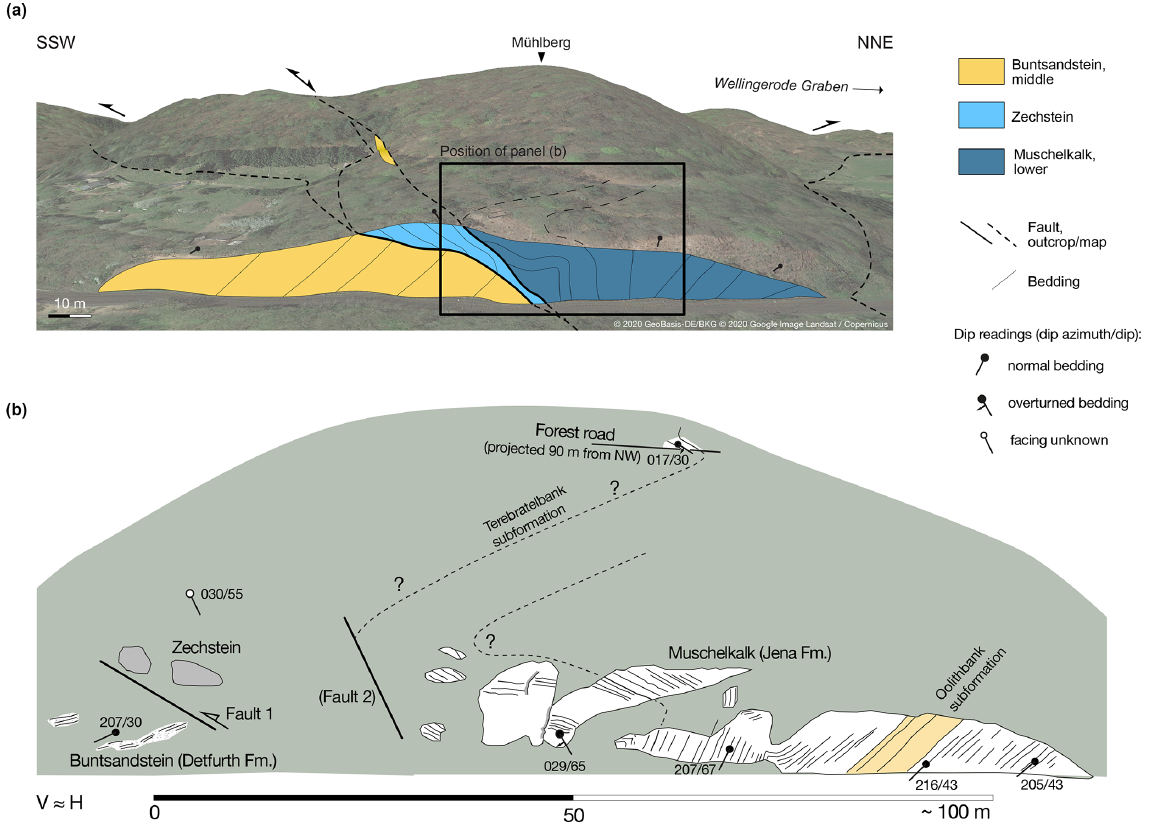
Figure 4. (a) Outcrop along the train tracks west of Sontra (Schröder, 1925) shown as an overlay on a GoogleEarth image with fault traces extrapolated according to our own field data. (Image position 51 ◦ 4 (cid:48) 57.35 (cid:48)(cid:48) N, 9 ◦ 56 (cid:48) 24.49 (cid:48)(cid:48) E, with a view towards NNW; © GeoBasis- DE/BKG 2020, © Google Image Landsat/Copernicus 2020). One of the exotic Zechstein slivers, with approximately fault-parallel bedding, is thrust onto the middle Buntsandstein of the graben shoulder. The lower Muschelkalk overlying the sliver in the NNE is the partly overturned limb of a contractional anticline. (b) The same outcrop in the year 2000, drawn after field book sketches. Key observations by Schröder (1925) could still be